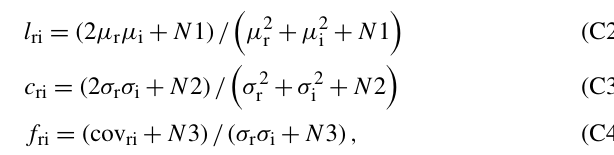
Table D1. Affine transform coefficients applied to the registered thermogram sequences of each flight along with the root mean squared values